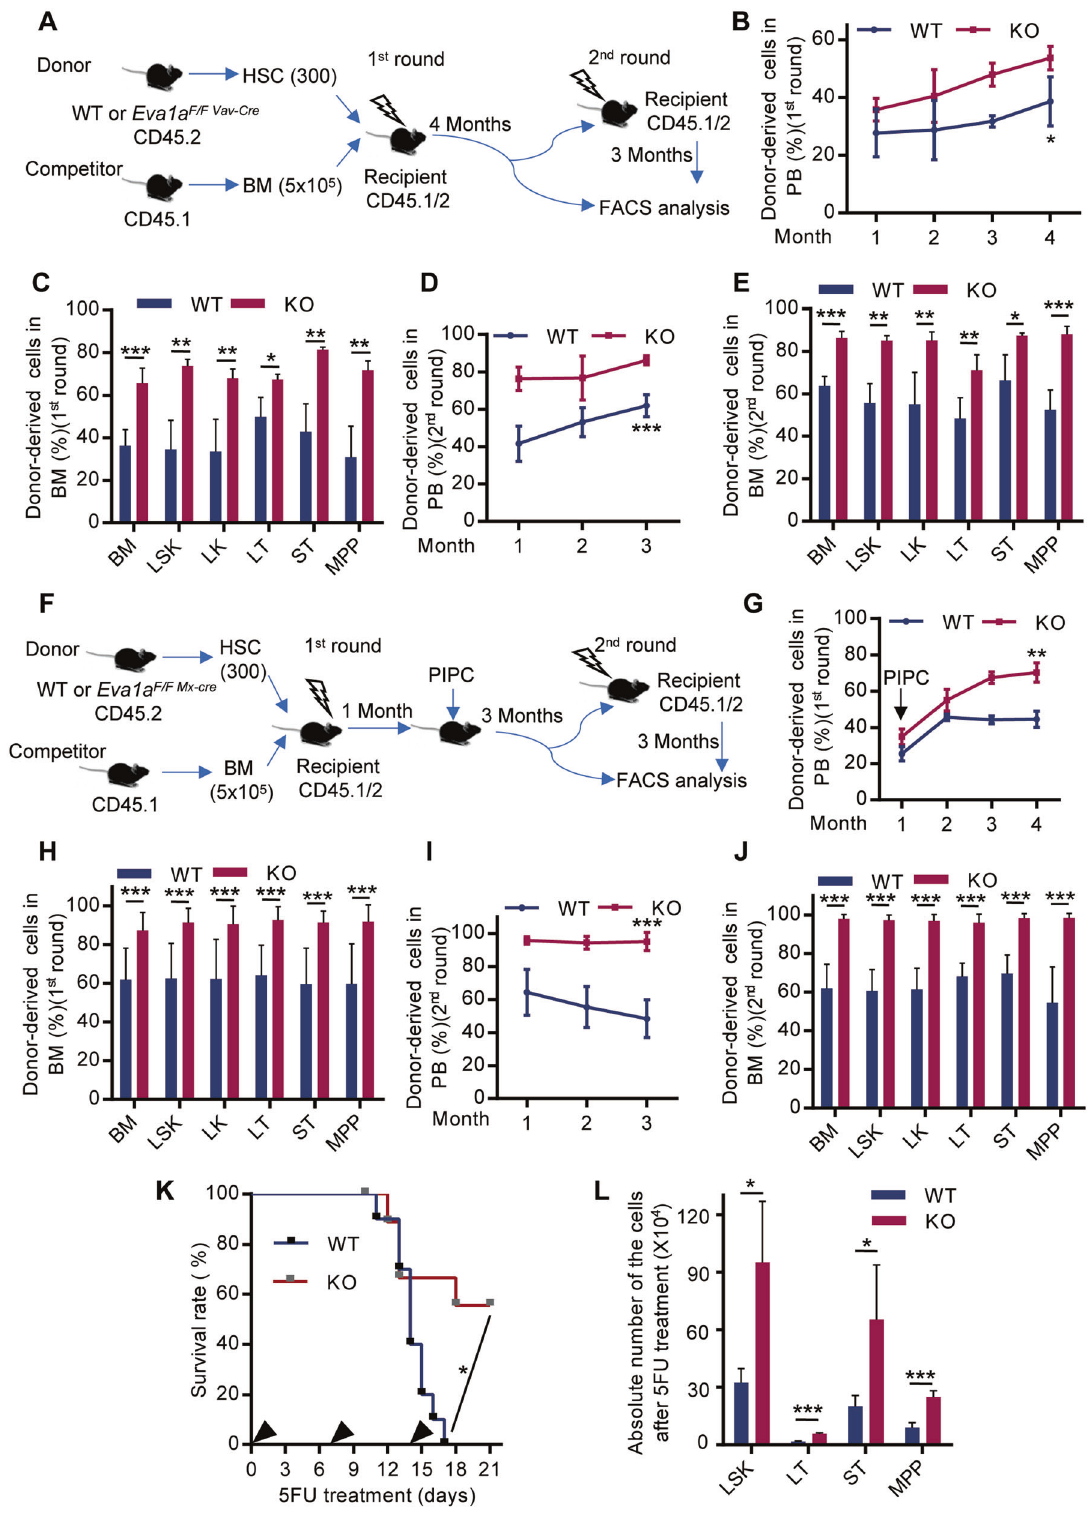
de fi cient HSPCs, we assessed the proliferation of Eva1a de fi cient HSPCs under 5FU treatment. The Ki67 staining showed a comparable proliferation of the WT and Eva1a de fi cient LSK after 5FU treatment (Fig. S5C). Lastly, the equivalent proliferation was also observed after transplantation in Eva1a knockout LSK cells